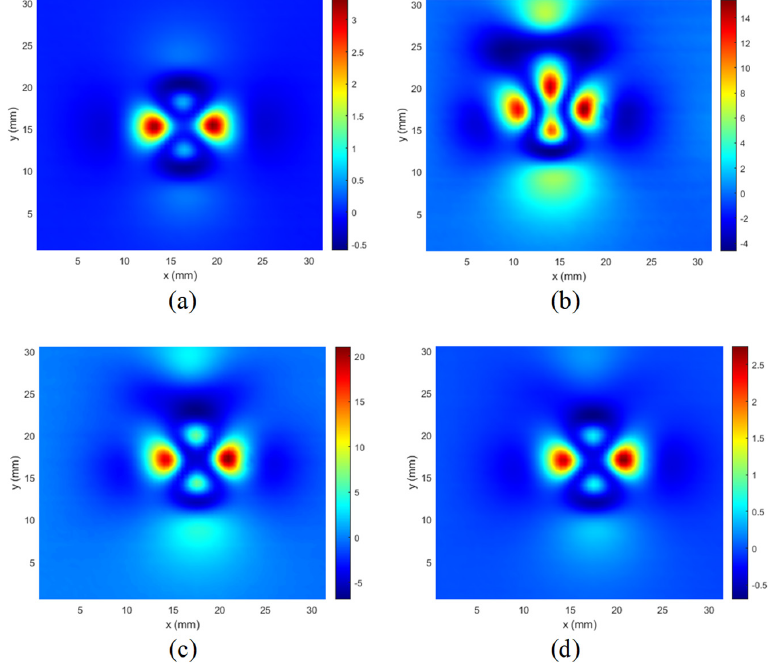
Figure 14. Comparison of C-scans: ( a ) achieved in case of the specimen without defect; ( b ) the specimens with the 5 mm long crack along the y -axis in the 1st layer; ( c ) in the 2nd layer; ( d ) in the 3rd